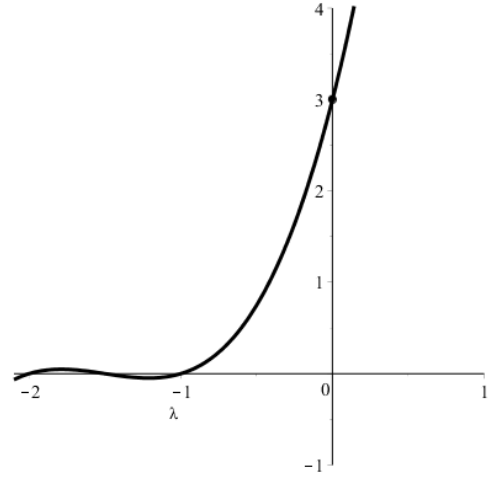
Figure A1. LHS of Equation (5) for γ = 1.5, β = 2, and σ + ρ aU 0 =